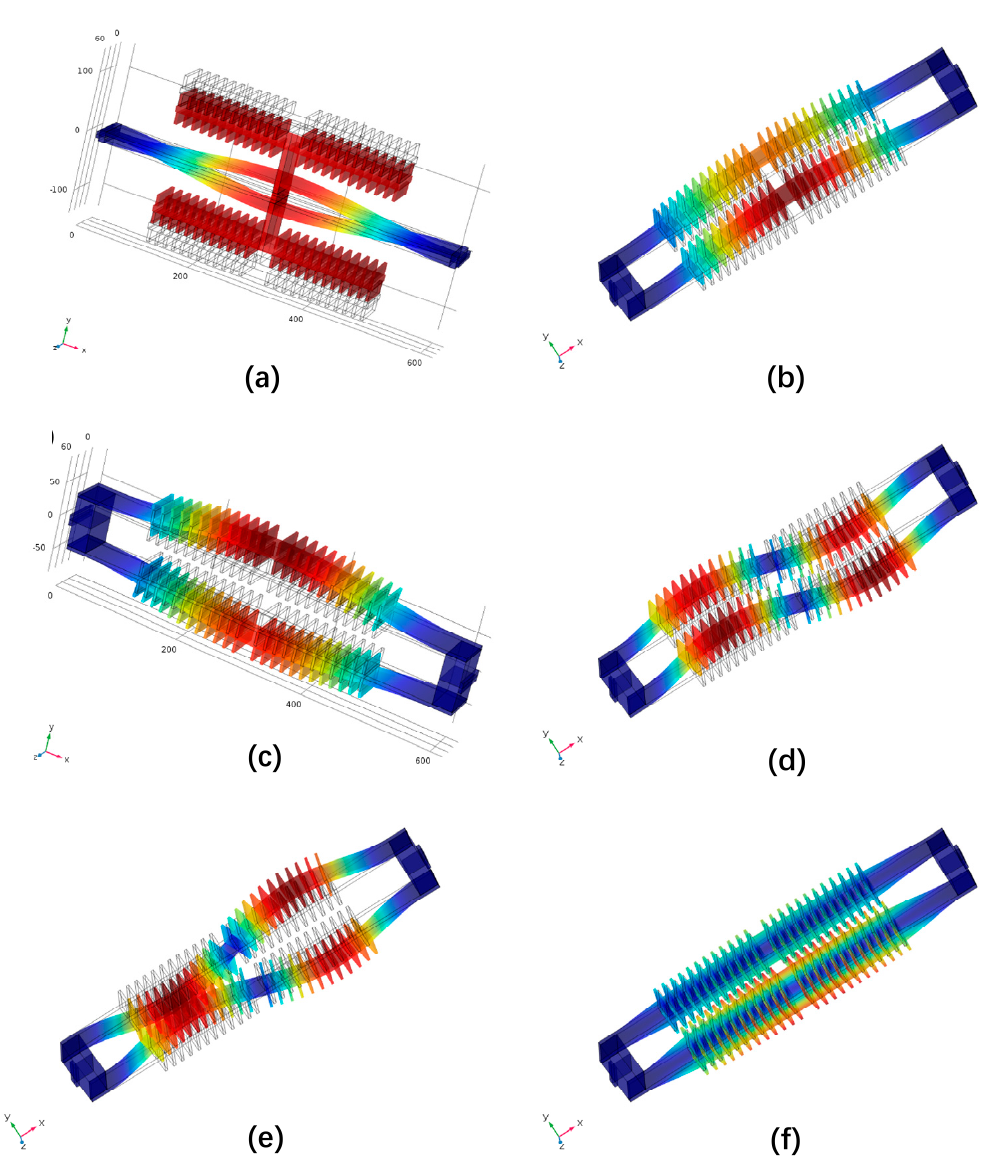
Figure 4. Simulated resonant modes of DETF under no loading force. ( a ) Drive mode of conventional design with airfoil additional mass DETF sensing structure; ( b ) 1st mode: in-plane translation mode; ( c ) 2nd mode: in plane drive mode; ( d ) 3rd mode: out-of-plane in-phase wriggle mode; ( e ) 4th mode: in-plane opposite wriggle mode; ( f ) 5th mode: in-phase torsional mode. Table 2. Modal analysis results of the designed DETF.